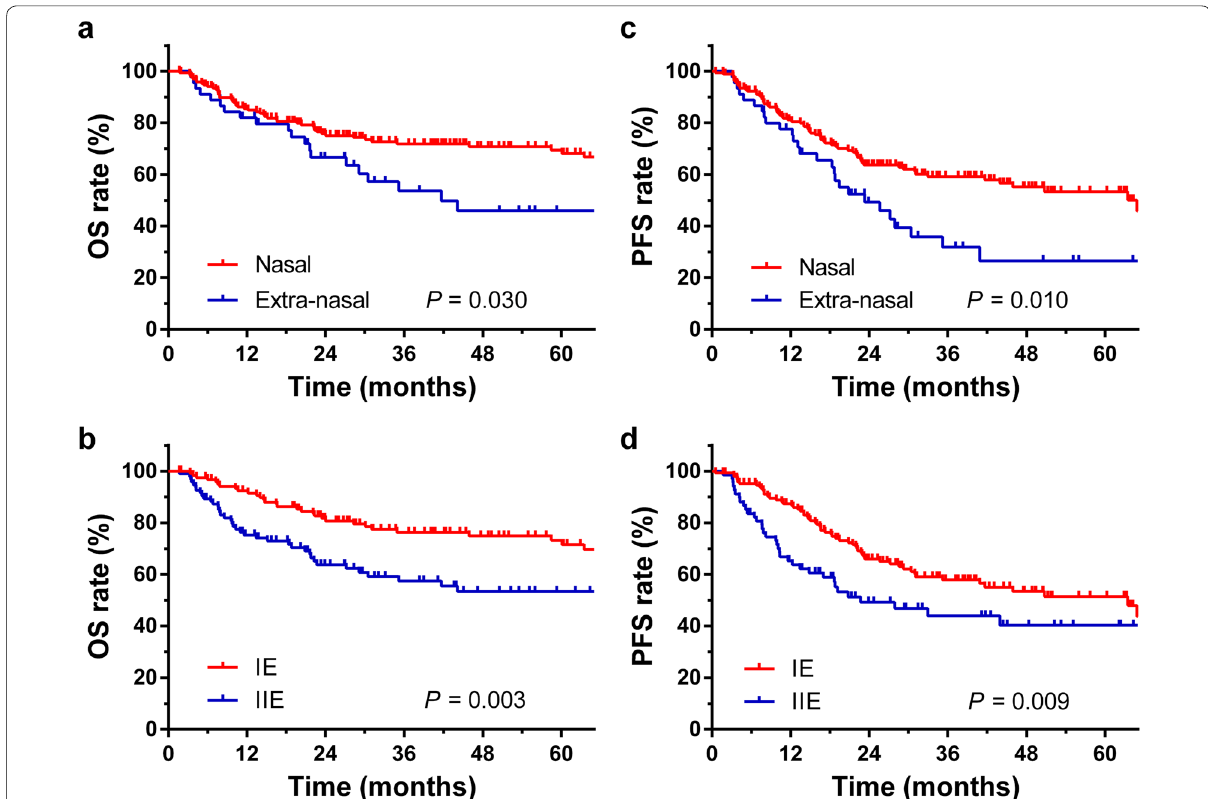
Fig. 2 Kaplan‑Meier OS and PFS curves for patients with ENKTCL categorized by primary site and regional lymph node involvement. a OS curves for patients with nasal and extra‑nasal disease; b OS curves for patients with Ann Arbor stage IIE or IE disease (i.e., with or without regional lymph node involvement); c PFS curves for patients with nasal and extra‑nasal disease; d PFS curves for patients with Ann Arbor stage IE or IIE